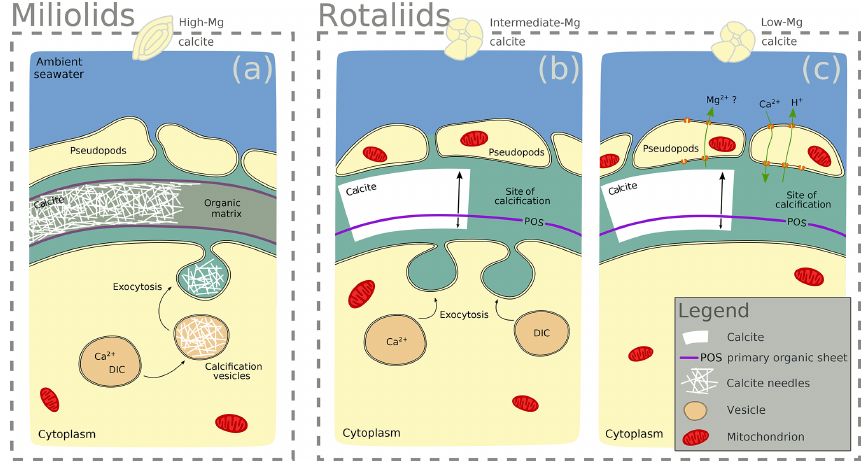
Figure 5. Scheme highlighting differences in the calcification mechanisms in miliolid and rotaliid foraminifera. Miliolid foraminifera pre- cipitate calcium crystals in intracellular vesicles prior to arranging them in the shape of the new chamber wall ( a ; Angell, 1980; Hemleben et al., 1986; Debenay et al., 1996, 1998, 2000; Bentov and Erez, 2006). Rotaliid foraminifera precipitate calcite onto organic templates within an extracellular but confined space, and they add a new lamella to the entire shell each time they produce a new chamber ( b, c ; Hemleben et al., 1986; de Nooijer et al., 2014). In intermediate-Mg calcite-producing rotaliid foraminifera (like A. lessonii ), the transport of vesicles to the site of calcification has been observed, suggesting controlled biomineralization (at least partly) from internal Ca and carbonate pools ( b ; e.g. de Nooijer et al., 2009). In rotaliid low-Mg calcite-producing foraminifera, selective ion transport to the site of calcification via the transmembrane pumping of elements is discussed as the biological control on biomineralization ( c ; Nehrke et al., 2013; de Nooijer et al., 2014; Toyofuku et al.,